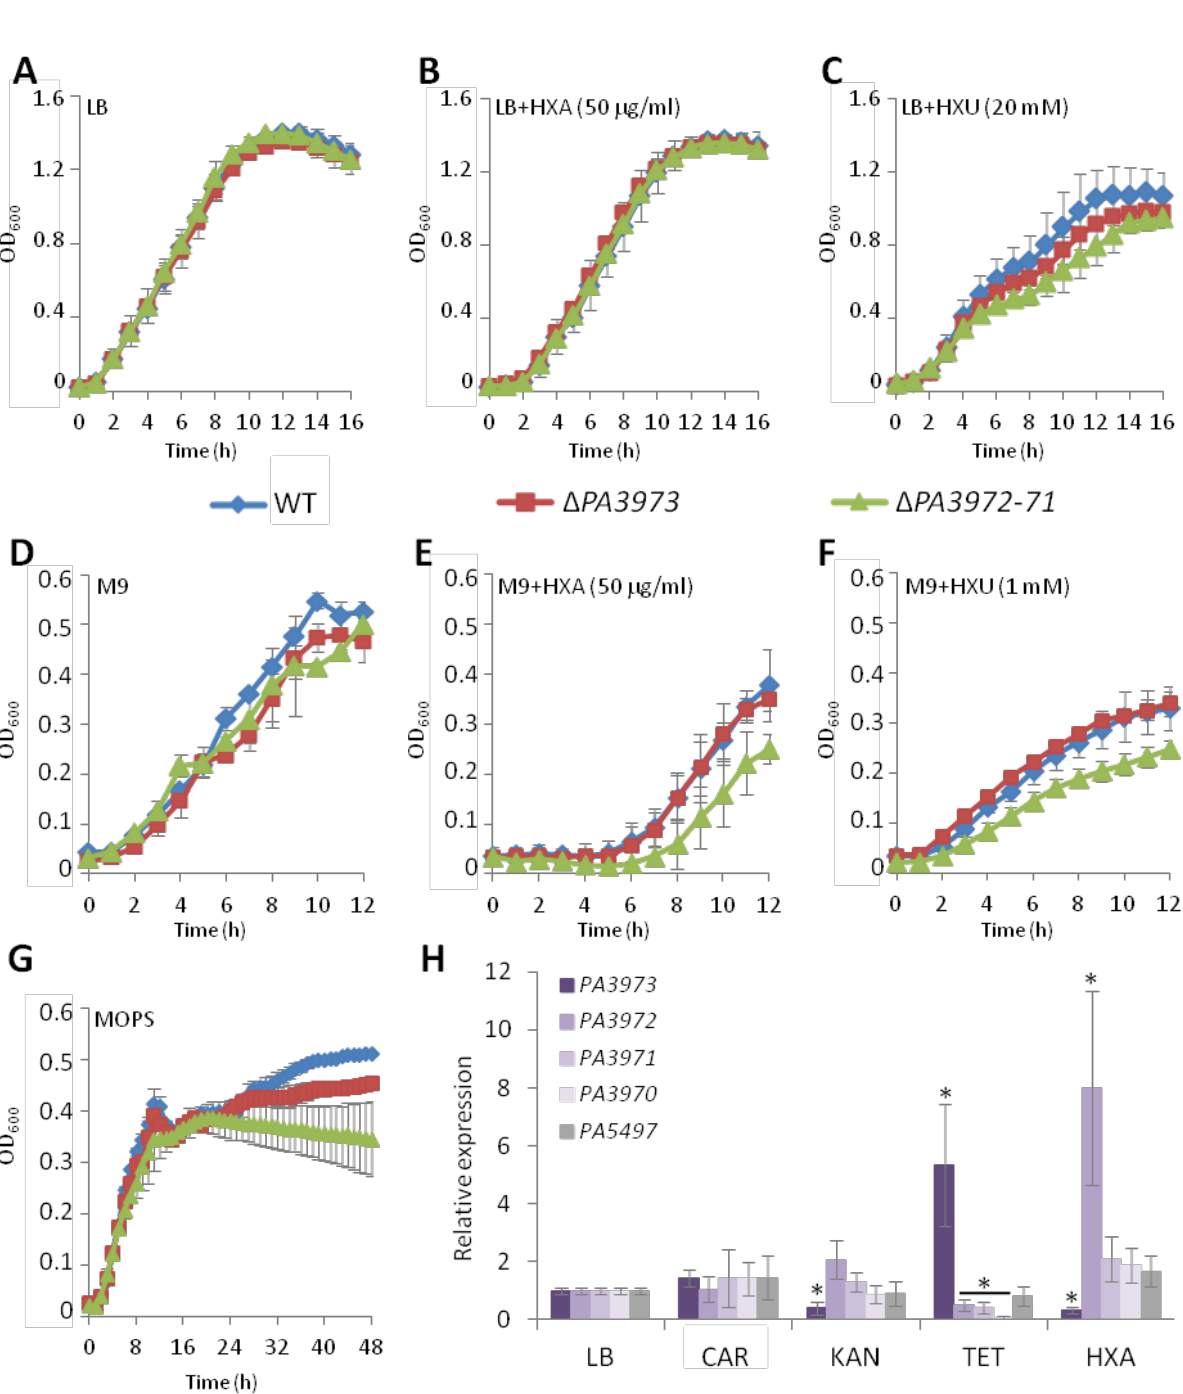
Figure 6. Involvement of PA3973 - PA3971 gene cluster in response of P. aeruginosa to stress. Kinetics of growth of P. aeruginosa strains PAO1161 WT, ∆ PA3973 and ∆ PA3972-71 at 37 ◦ C in indicated media in the presence of hydroxylamine and hydroxyurea: LB ( A ), LB + 50 µ g/mL hydroxylamine ( B ), LB + 20 mM hydroxyurea ( C ), M9 + glucose ( D ), M9 + glucose + 50 µ g/mL hydroxylamine ( E ), M9 + glucose + 1 mM hydroxyurea ( F ), MOPS + glucose ( G ). Data represent mean ± SD from three independent experiments. HXA-hydroxylamine; HXU-hydroxyurea. ( H ) Relative expression of indicated genes in WT PAO1161 cells cultured in LB medium without antibiotic [LB] and with different classes of antibiotic added at subinhibitory concentrations: carbenicillin, 32 µ g/mL [CAR]; kanamycin, 10 µ g/mL [KAN], and tetracycline, 4 µ g/mL [TET]. Additionally, the expression of indicated genes in cells grown with hydroxylamine (50 µ g/mL) [HXA] added to the medium was tested and compared to the control [LB]. * p < 0.05 in a Student two-sided t -test assuming equal